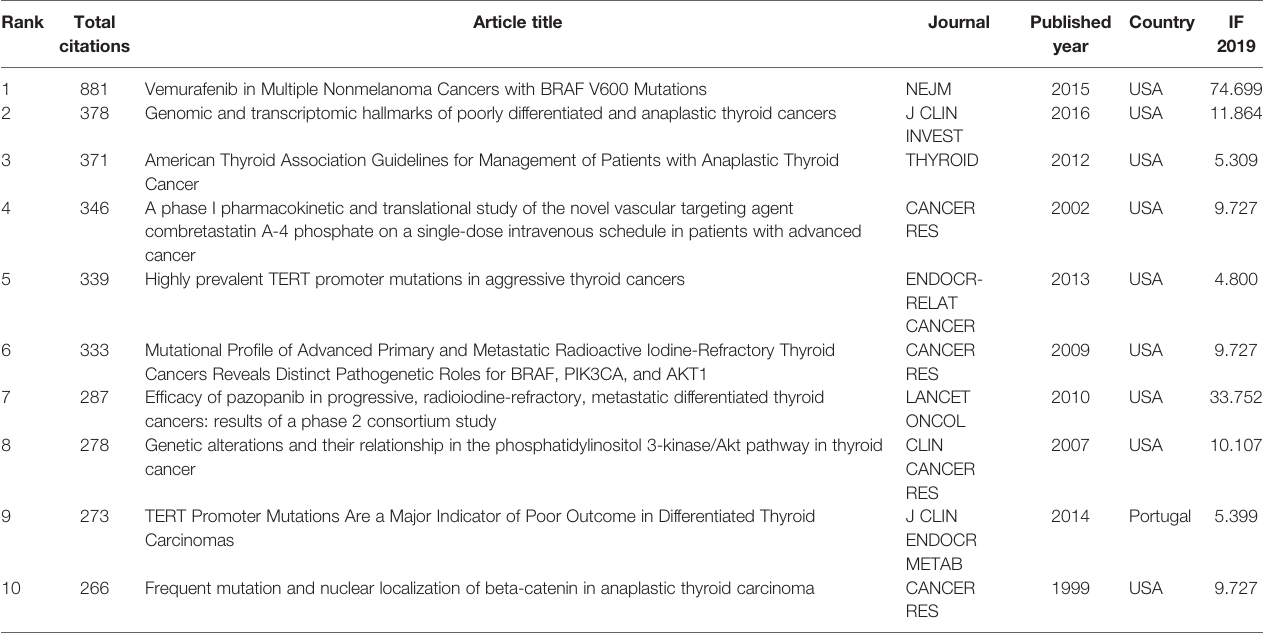
TABLE 3 | The characteristics of highly cited and the most impact classic articles in ATC fi